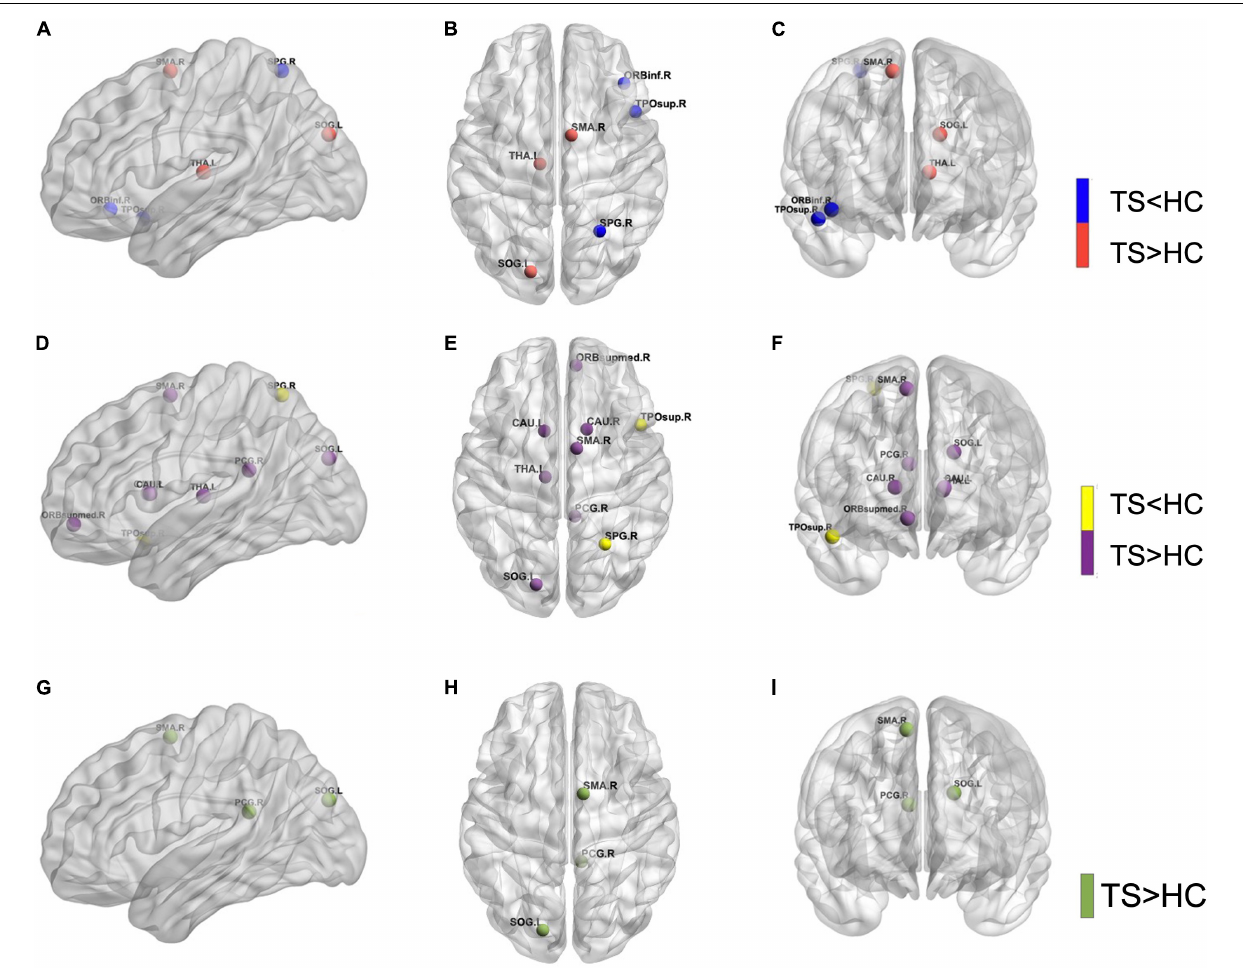
FIGURE 1 | The significant alternations of nodal betweenness (A–C) , nodal degree (D–F) , and nodal efficiency (G–I) of gray matter (GM) in pediatric Tourette syndrome and healthy controls. CAU, caudate nucleus; HC, healthy control; L, left; ORBinf, inferior frontal gyrus, orbital part; ORBsupmed, superior frontal gyrus, medial orbital; PCG, posterior cingulate gyrus; R, right; SMA, supplementary motor area; SOG, superior occipital gyrus; SPG, superior parietal gyrus; THA, thalamus; TPOsup, temporal pole: superior temporal gyrus; TS, Tourette